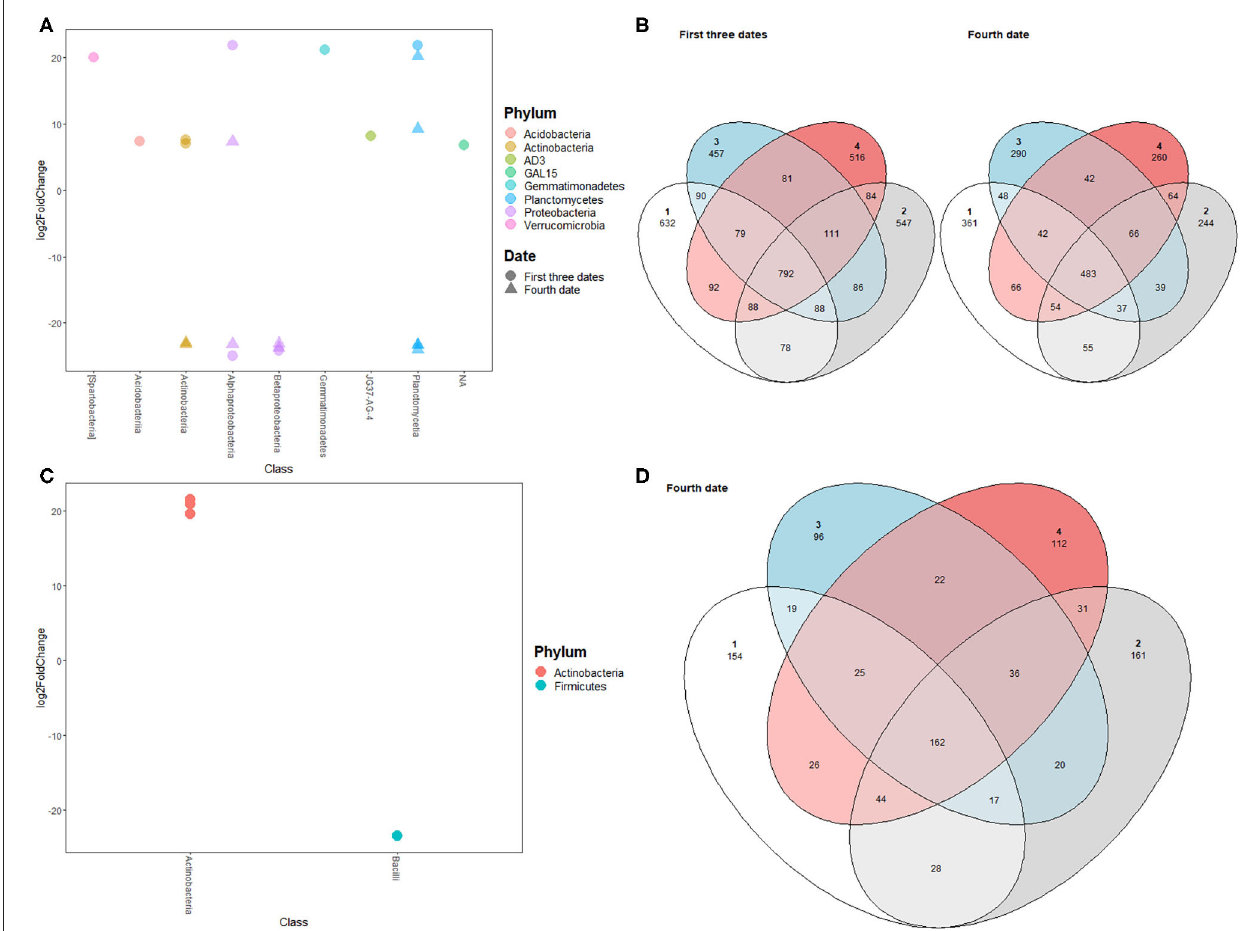
FIGURE 4 | (A) Prokaryotic ASVs differentially detected between block 1 and blocks 2, 3, and 4 for bulk soil prokaryotic communities during the first three sampling dates (circle) and the fourth sampling date (triangle); (B) Venn diagram showing shared prokaryotic ASVs between different blocks for bulk soil at first three sampling dates (left diagram) and fourth sampling date (right diagram); (C) Prokaryotic ASVs differentially detected between block 1 and blocks 2, 3, and 4 for rhizospheric prokaryotic communities; (D) Venn diagram showing shared ASVs between different blocks for rhizospheric prokaryotic communities.